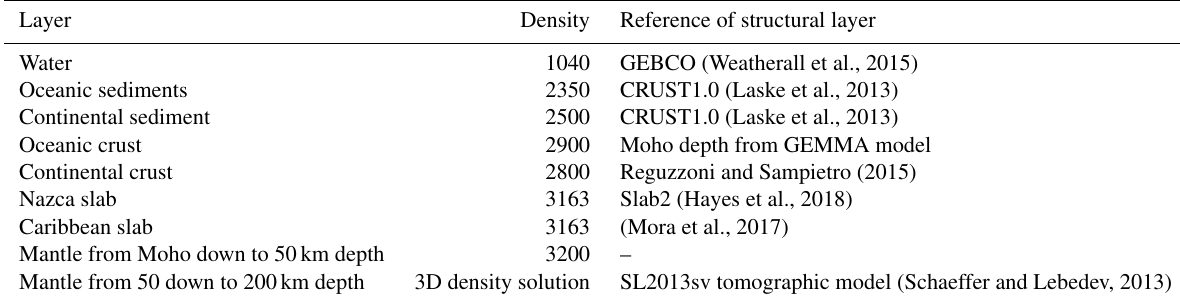
Table 1. Summary of the datasets used to constrain the initial 3D lithospheric-scale model of the South Caribbean and north-western South American plate and the density values (kgm − 3 ) assumed for each